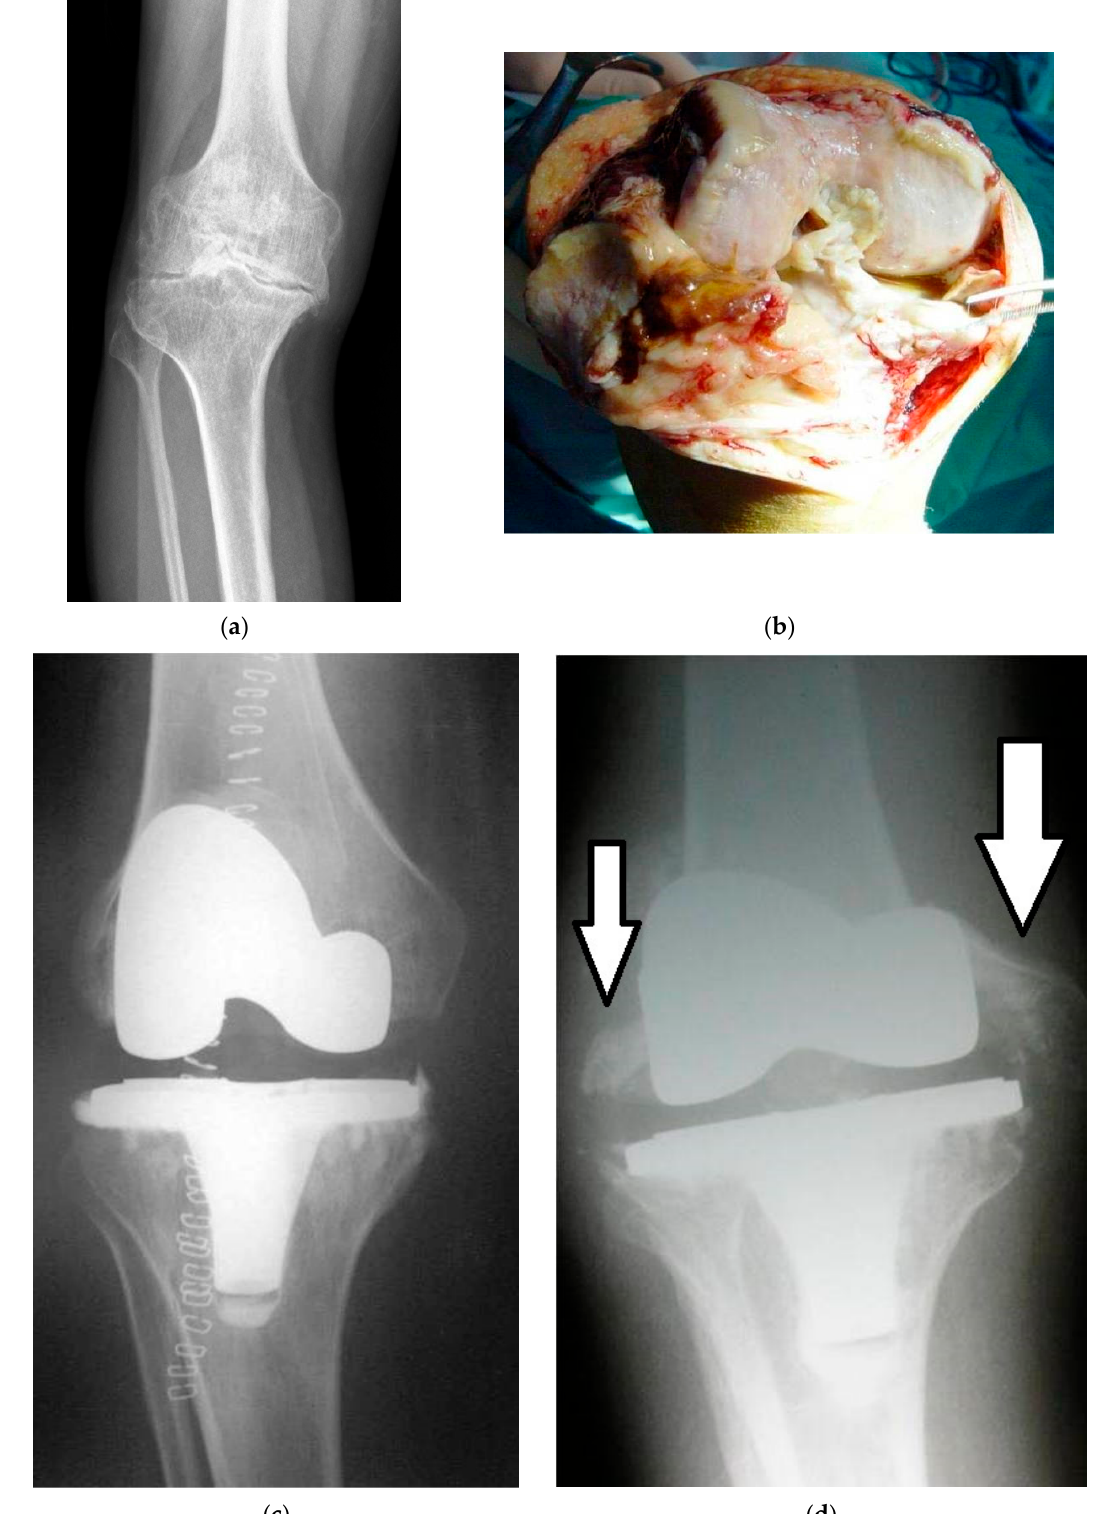
Figure 1. ( a – d ). Staphyloccocus aureus infection of a primary total knee arthroplasty (TKA): ( a ) Preoperative radiograph showing severe knee osteoarthritis; ( b ) Intraoperative image showing severe joint degeneration caused by osteoarthritis; ( c ) Immediate postoperative radiograph showing the implanted primary TKA (posterior stabilised cemented); ( d ) Radio- graphic image 5 months postoperatively showing severe osteolysis of the femoral condyles (arrows) due to periprosthetic joint infection (PJI). This patient required a two-stage revision arthroplasty in order to cure the infection.